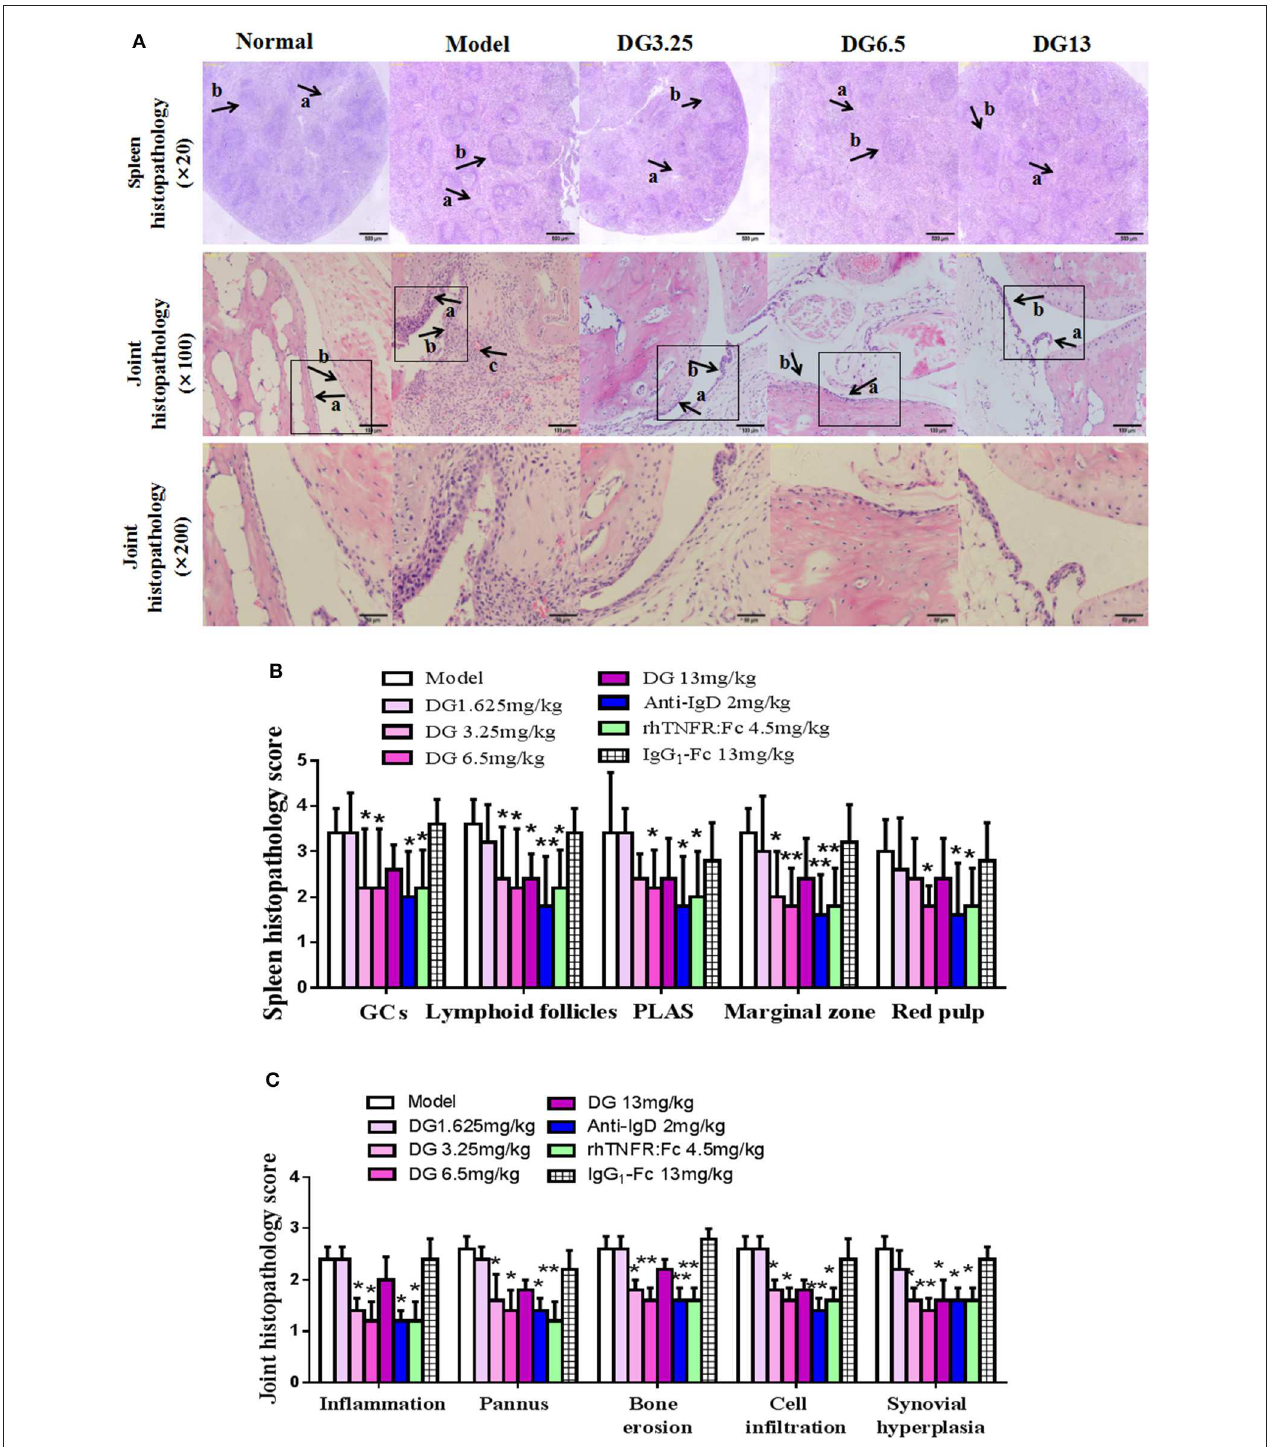
FIGURE 6 | Effects of IgD-Fc-Ig (DG) on ankle joints and spleens histopathology of CIA mice. (A) A photomicrograph of spleen histopathology showing red pulp congestion (arrow a), and white pulp proliferation (arrow b). Original magnification × 20. A photomicrograph of ankle joint histopathology showing synoviocyte hyperplasia (arrow a), cellular infiltration (arrow b), articular cartilage destruction and pannus (arrow c). Original magnification × 100 and × 200. (B) Histological appearance was scored for the presence of the total number of GCs, lymphoid follicles, PALS, marginal zone the red pulp in mice spleens. (C) Histological appearance was scored for the presence of inflammation, pannus, bone erosion, cell infiltration, and synovial hyperplasia in mice ankle joints. Data were expressed as mean ± SEM (For each group 5–9 mice). * P < 0.05 and ** P < 0.01 vs. Model.